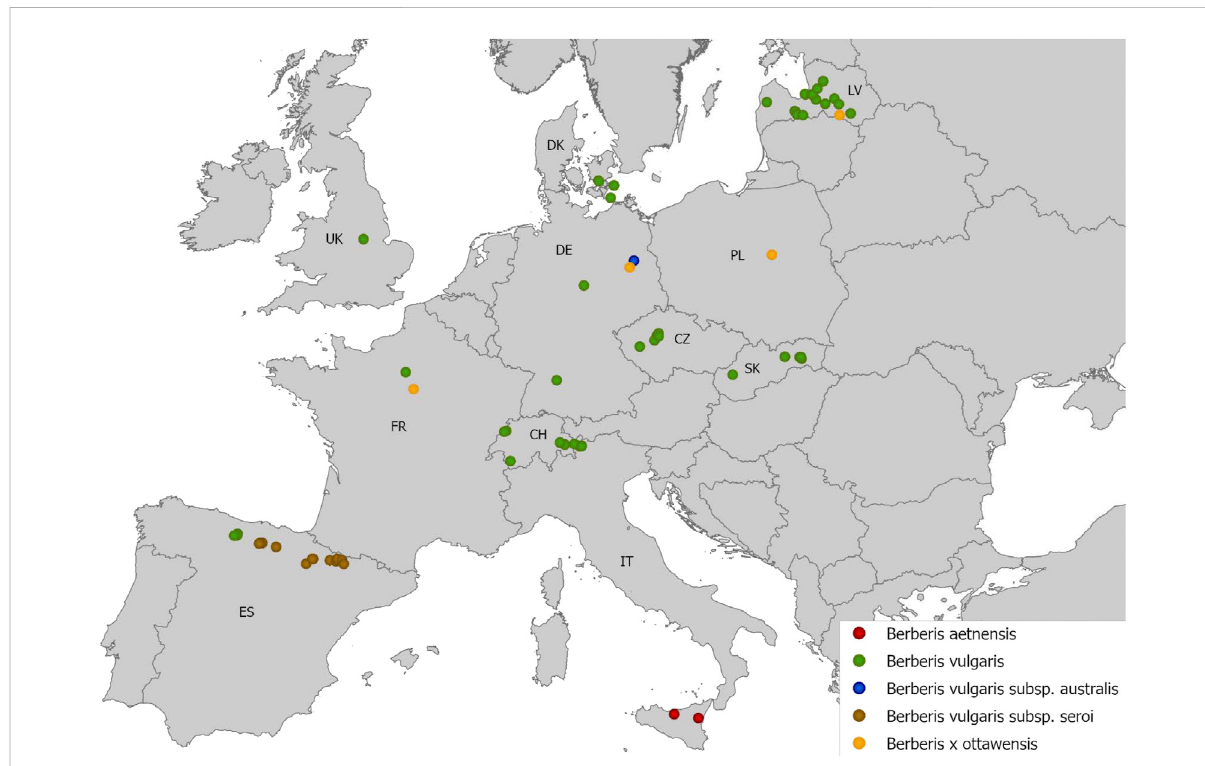
FIGURE 1 Infected barberry leaves were collected from fi ve barberry species at multiple sites in 11 European countries, i.e., CZ: Czech Republic, CH: Switzerland, DE: Germany, DK: Denmark, ES: Spain, FR: France, IT: Italy, LV: Latvia, PL: Poland, SK: Slovakia, UK: United Kingdom (seeSupplementary Table S1 for detailed survey